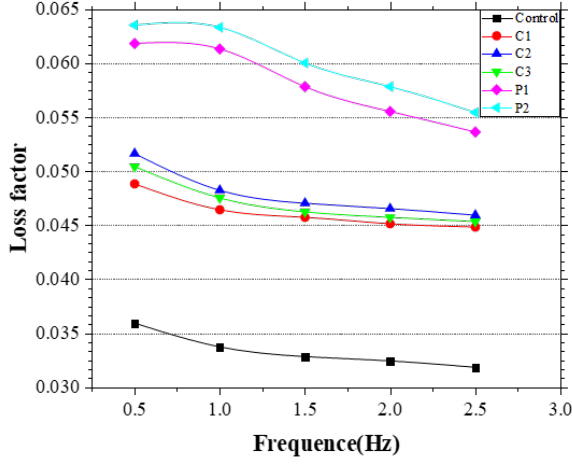
Figure 12: Loss factors of MDF cements obtained by DMA